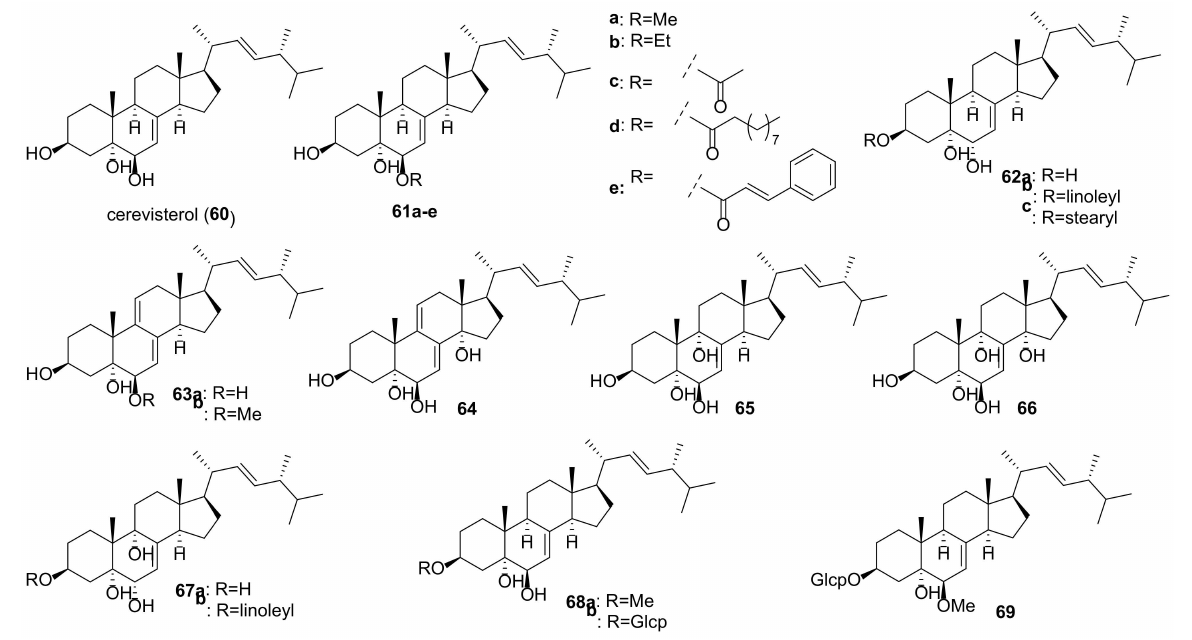
Figure 9. Structures of fungal steroids with a 5 α ,6-diol fragment and their O -derivatives.